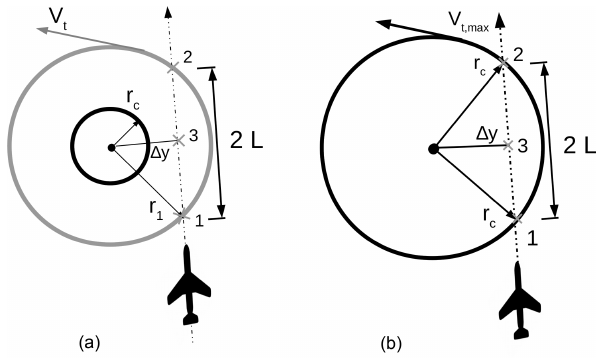
Figure 9. Schematic of the UAS passing a vortex in the horizon- tal plane (top-down view). Two different cases have to be distin- guished: the closest distance to the vortex (cid:49)y > r c (a) and the pass- ing distance (cid:49)y < r c (b)